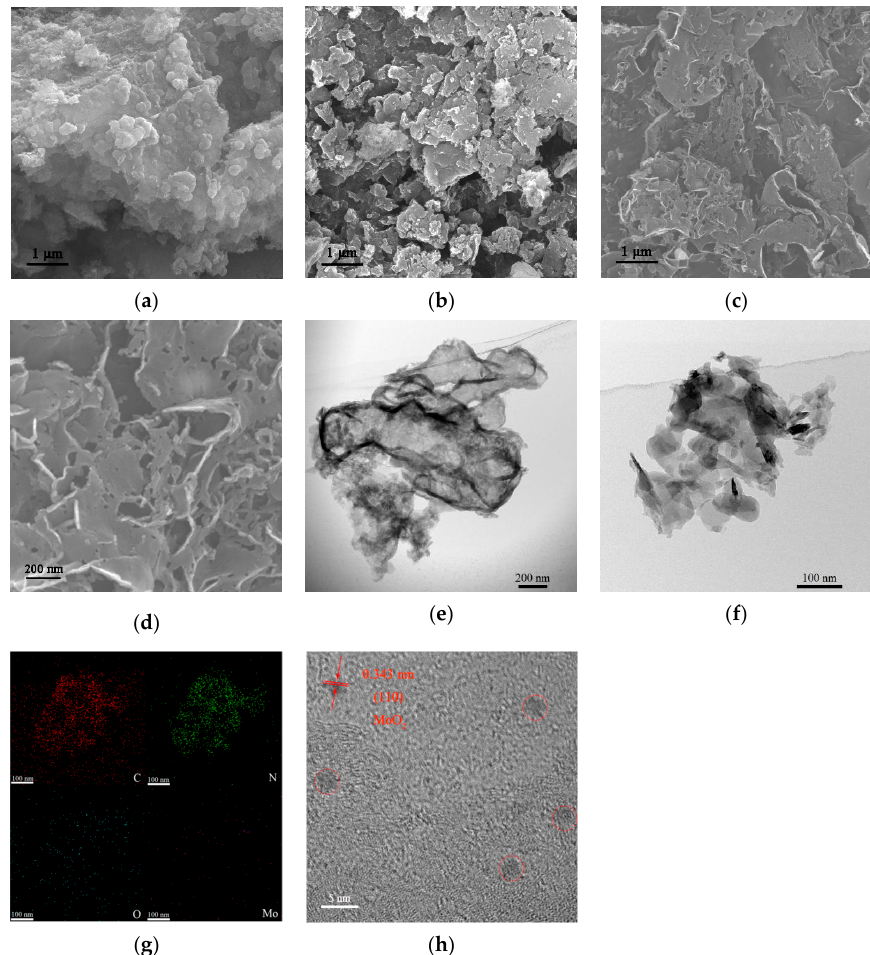
Figure 1. Microstructures of the prepared samples. Typical SEM images: low-magnification for ( a ) bulk g-C 3 N 4 and ( b ) CNH, and ( c , d ) different, higher magnification for CNM-4. Typical TEM images of ( e ) CNH and ( f ) CNM-4. EDX elemental mapping ( g ) and HRTEM ( h ) images corresponding to CNM-4.